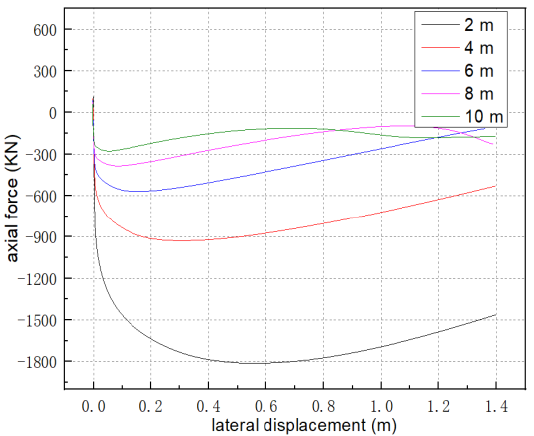
Figure 7. Influence of initial imperfection in the axial force – lateral displacement graph. Table 5. Critical axial force of initial imperfection.